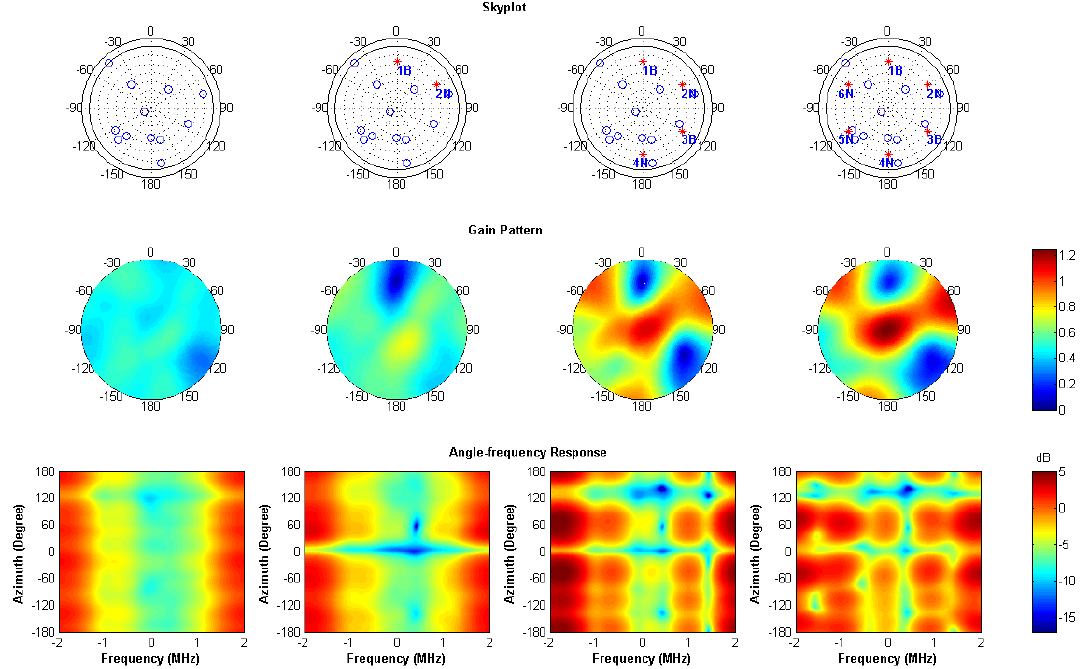
Figure 16. All-in-view CRPA channels C/N